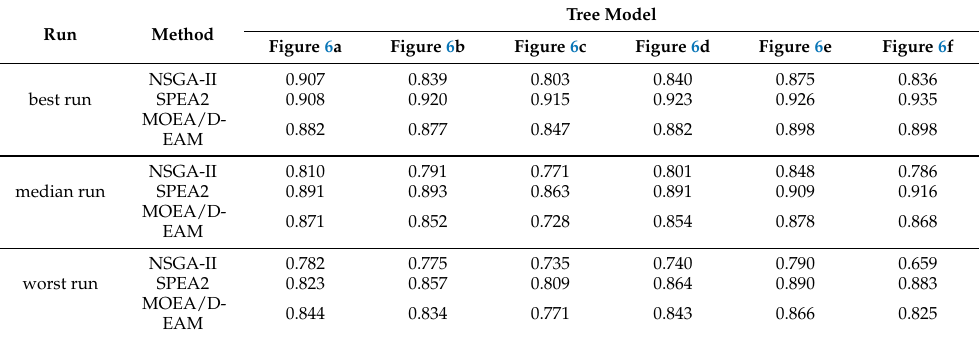
Table 4. The I H values for non-dominated sets produced by best, median, and worst runs of each optimization method. The metric is computed across the combined results of all three methods for a given run.